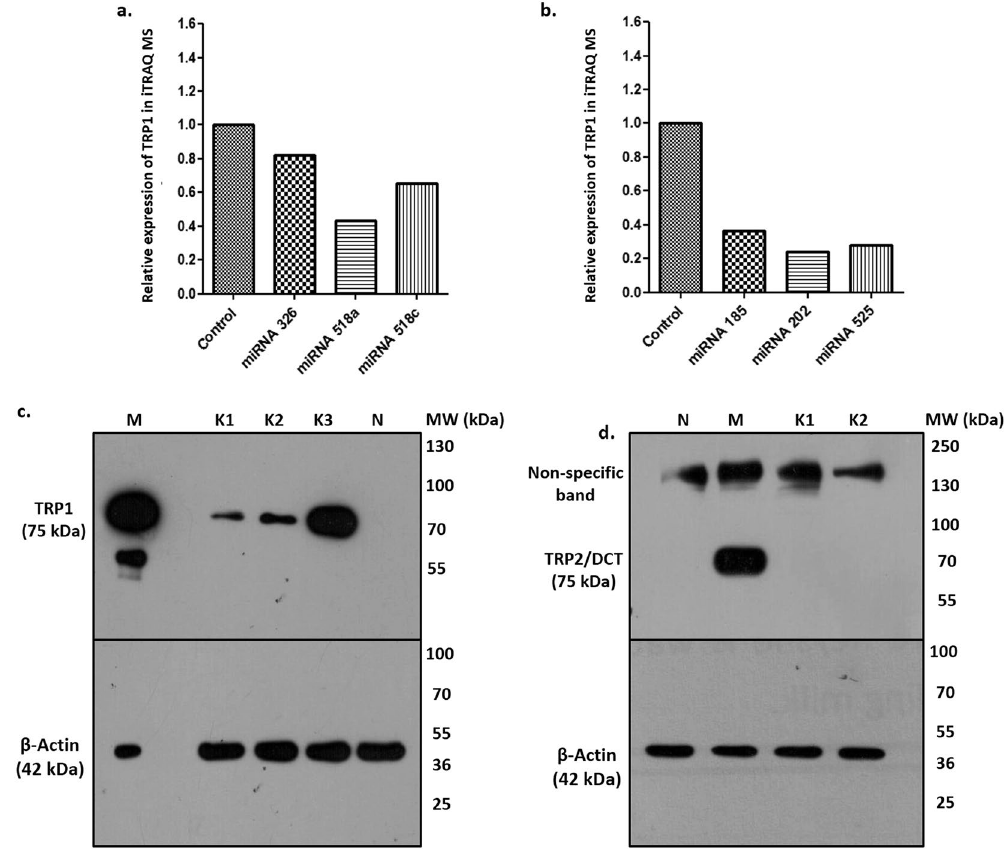
Figure 3. Expression of Tyrosinase related protein 1 (TRP1) in keratinocytes: ( a , b ) show relative expression of TRP1 protein in six miRNA transfected Keratinocytes compared with control as revealed by iTRAQ Mass Spectrometry. ( c ) Expression of TRP1 at protein level in Keratinocyte cell lysates in K1, K2 and K3 samples shows variable expression. M is Melanocyte lysate used as positive control where TRP1 expression is very abundant, N is NIH3T3, negative control, where there is no expression of TRP1.Full gel pictures of this cropped gel are shown in Supplementary Fig. 11. The lower Immunoblot represents β -Actin as loading control. ( d ) Expression of TRP2/DCT in NIH3T3 (N), melanocytes (M) and two samples of keratinocyte cultures K1 and K2, to show the expression of the melanogenic protein only in melanocytes and not in keratinocytes, full gel pictures are shown in Supplementary Fig.